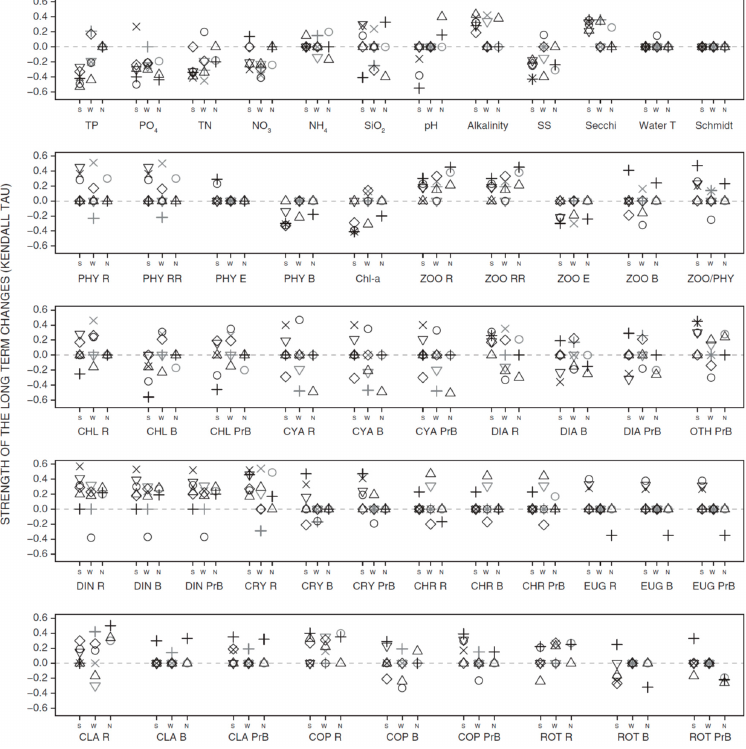
Figure A6. Summary of monotonic long ‐ term trends in lake and plankton variables analysed for spring. For details see Figure 4. Water 2016 , 8 , 427